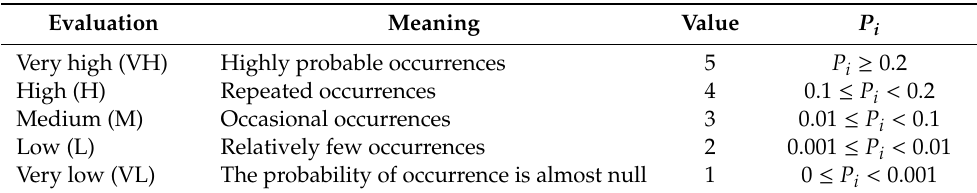
Table 3. Evaluation scale for the factor of occurrence.